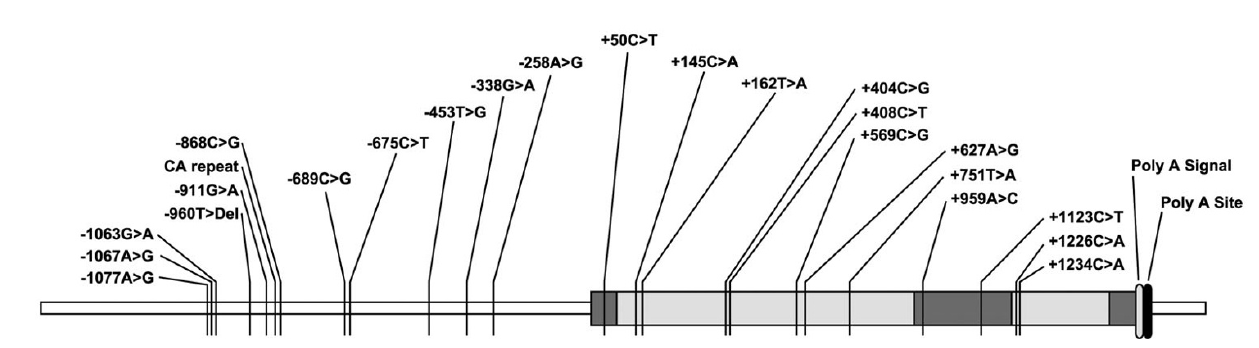
Table 2: Minor allele frequencies of the 23 SNPs detected in the PI3 gene. GenBank entry position